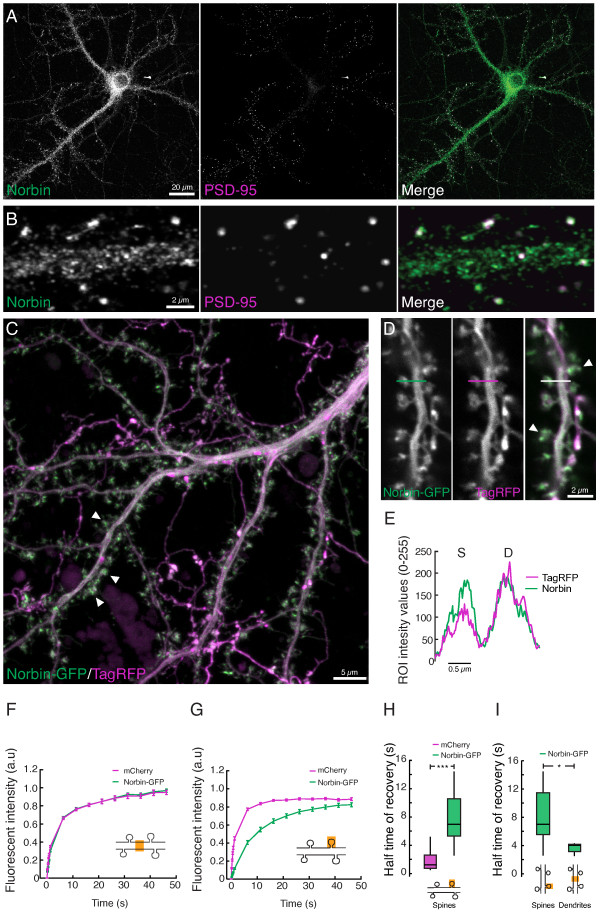
Norbin localizes to and accumulates in dendritic spines of hippocampal neurons. A) Confocal images of neurons showing immunolabeling of Norbin and PSD-95. Norbin is localized in the soma and dendrites. B) A higher magnification shows that Norbin is localized to dendritic spines. C-D) Confocal images of neurons co-transfected with Norbin-GFP and TagRFP showing Norbin accumulated in spines (arrows). E) An intensity plot of the line in D shows the relative accumulation of Norbin-GFP in spines. F-I) Fluorescent recovery after photobleaching (FRAP) experiments in neurons co-transfected with Norbin-GFP and mCherry. F) In dendrites, there was no difference in recovery half times between Norbin and mCherry (tNorbin = 3.7 ± 0.2 s, tmCherry = 3.2 ± 0.2 s, mean ± SEM, p > 0.5, Kruskal-Wallis test, n = 11). G, H) In spines, recovery half times were significantly different between Norbin and mCherry (tNorbin = 8.0 ± 0.4 s and tmCherry = 1.9 ± 0.2 s, mean ± SEM, ***p < 0.0001, Kruskal-Wallis test, n = 59). I) Norbin-GFP had a longer half time of recovery in spines than in dendrites (8.0 ± 0.4 s vs. 3.7 ± 0.2 s, mean ± SEM, *p < 0.05, Kruskal-Wallis test).